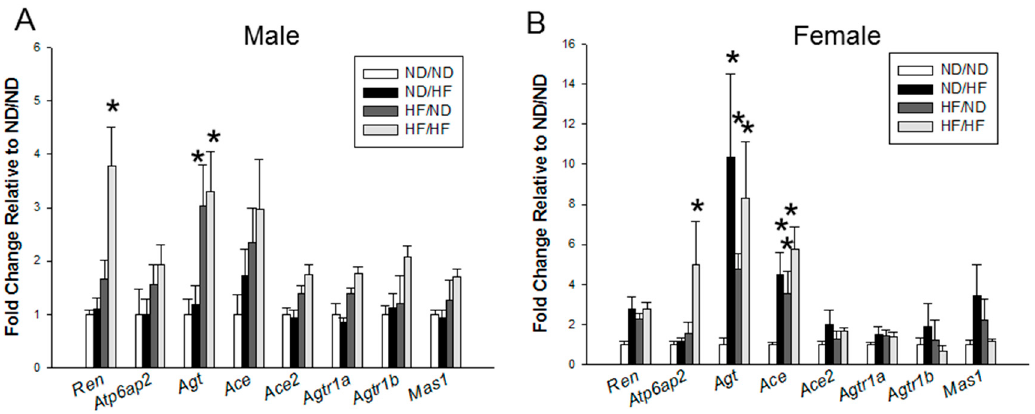
Figure 5. Effects of maternal and postnatal high-fat diet (HF) on gene expression of RAS components in: ( A ) male; and ( B ) female offspring. * p < 0.05 vs. ND/ND.